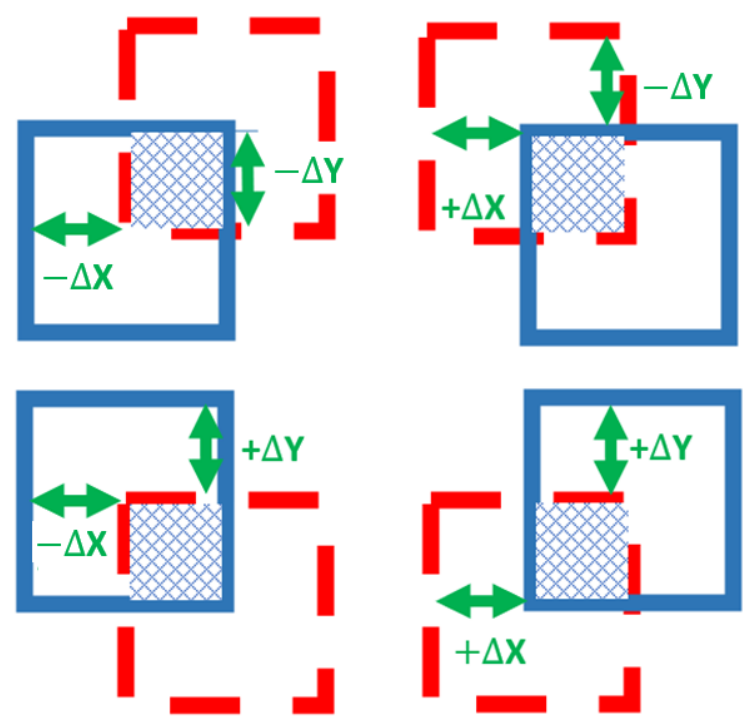
Figure 2. The four cases of intersection area between the old and new zones .